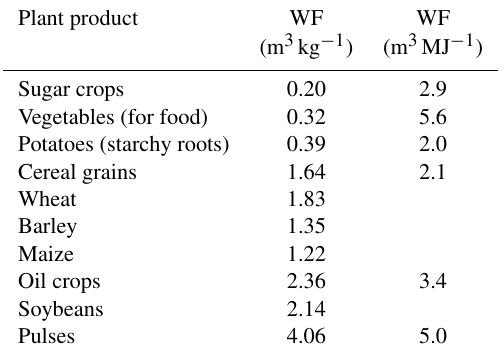
Table 2. Water footprint (WF; sum of green, blue and grey water) of some selected plant products (Mekonnen and Hoekstra, 2010).